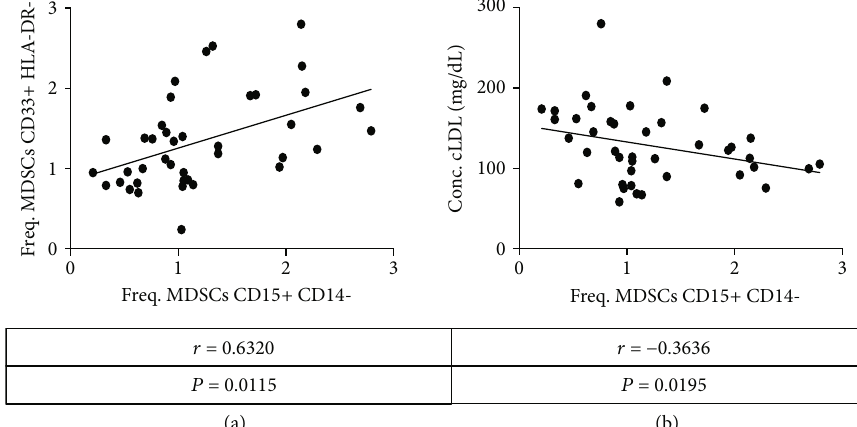
Figure 4: Correlation of MDSC frequency with cardiovascular markers. (a) Correlation between Freq. CD15+ CD14- and CD33+ HLA- DR-/low MDSCs. Data from 44 subjects, including groups in DM2 and nondiabetic controls. (b) Correlation between the concentration of LDL cholesterol and Freq. CD15+ CD14- MDSCs. Shown data are from 44 subjects (DM2 and nondiabetic controls). It was considered as statistically signi fi cant if value of P < 0 : 05 . Statistical analysis was performed with the GraphPad Prism ® v5.0